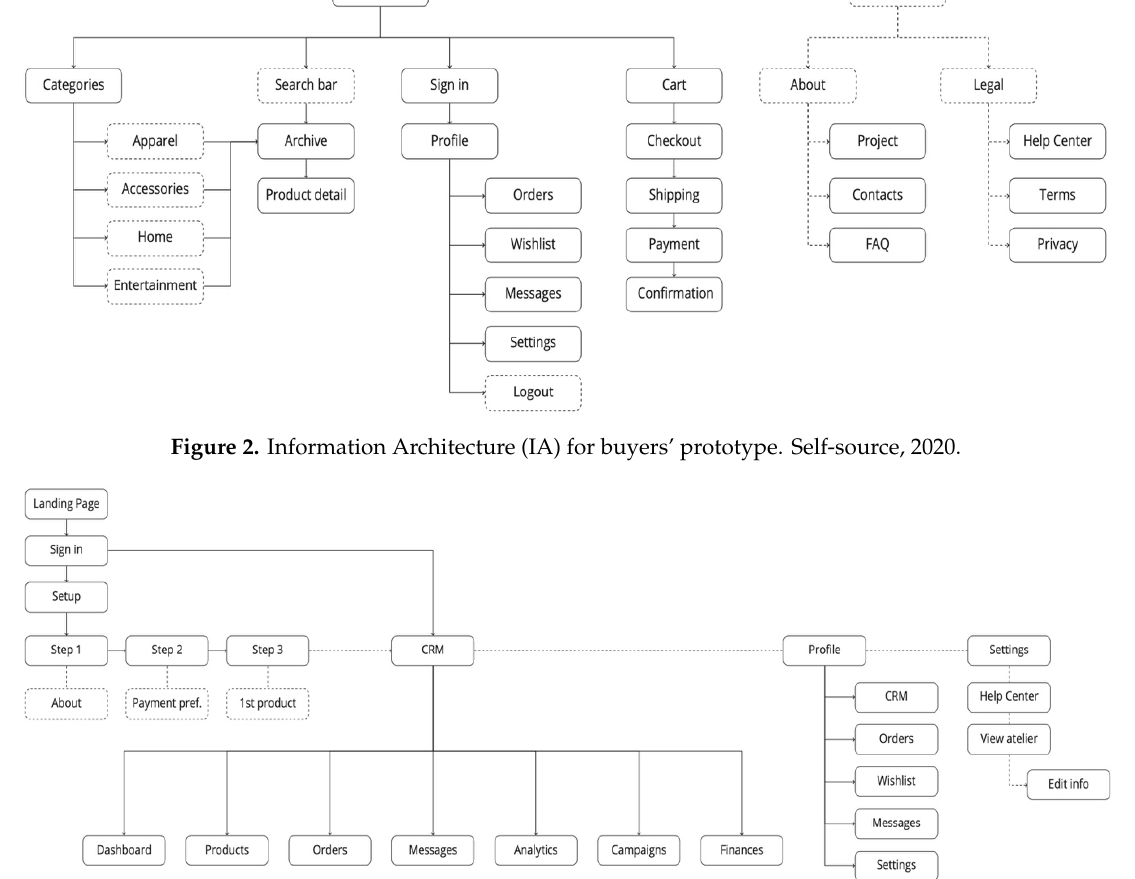
Figure 3. IA for sellers’ prototype. Self-source, 2020.